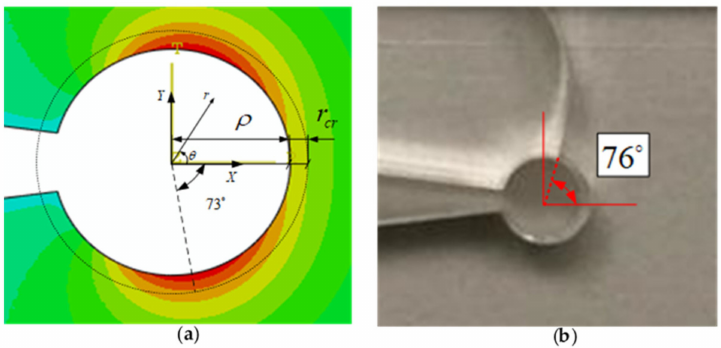
Figure 10. Crack initiation angle for DCB 2 specimen with notch radius 2.5 mm and opening angle 15 ◦ . ( a ) The finite element analysis; ( b ) experimental result.